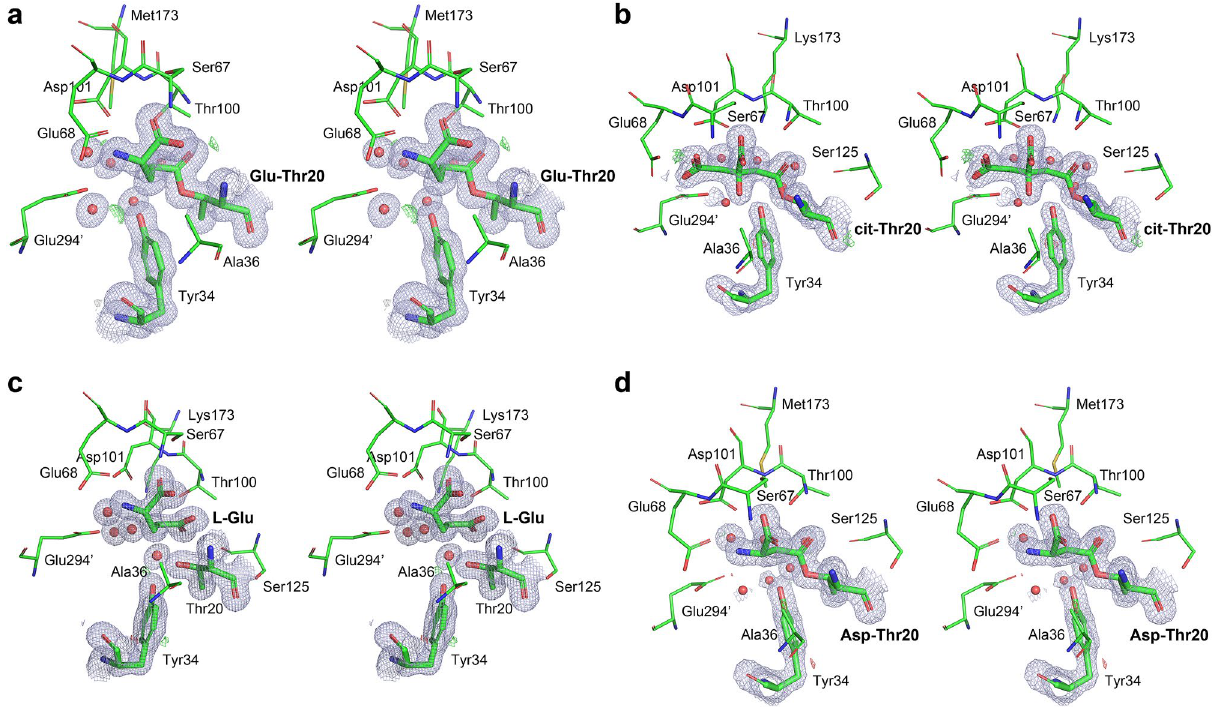
Figure 2. Representative electron densities of the ligands and parts of the active sites of PGA. For clarity, the 2mF o -DF c maps, contoured at 1.0·σ level (blue) cover only the ligands, solvent, and the most labile components of the active site. No significant peaks are visible in the m F o - D F c difference maps extending over the entire active site at the contour levels ± 3·σ. ( a ) Covalent acyl-enzyme intermediate L-Glu-Thr20, found in the active site of PGA(K173M) mutant (structure 6, resolution 1.15 Å), crystallized at pH 5. ( b ) Covalent acyl-enzyme intermediate, citrate-Thr20, found in the active site of PGA(wt) crystallized at pH 5.5 (structure 7, resolution 1.70 Å). ( c ) L-Glu bound non-covalently in the active site of PGA(wt) crystallized at pH 6.5 (structure 3, resolution 1.35 Å). ( d ) Covalent acyl-enzyme intermediate L-Asp-Thr20 found in the active site of the PGA(K173M) mutant (structure 5, resolution 1.58 Å) crystallized at pH 6. Figure was prepared with the licensed programs PyMol ver. 2.3.2, (Schrodinger LLC) and Adobe Photoshop CC